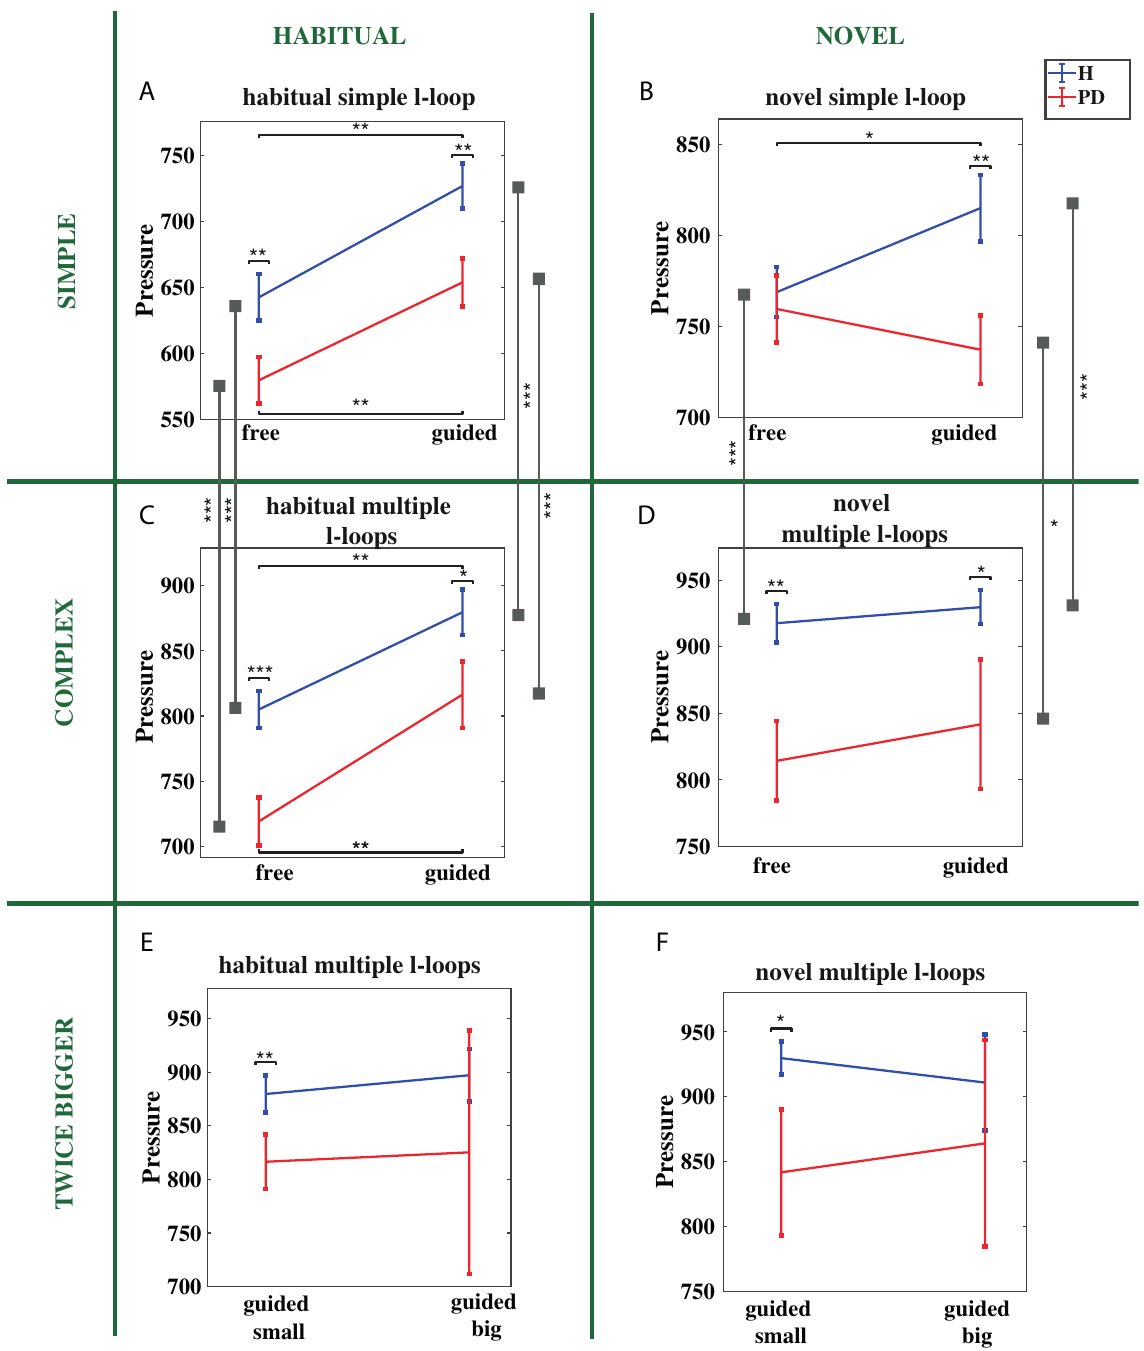
Figure 5. Pressure (mean ± SEM) across PD patients (red lines) and H subjects (blue lines) for all conditions: ( A ) Habitual simple l-loop, ( B ) Novel simple l-loop, ( C ) Habitual multiple l-loops, ( D ) Novel multiple l-loops, ( E ) Habitual multiple l-loops, ( F ) Novel multiple l-loops. Grey and black lines indicate the results of t -tests that gave significant differences. Stars indicate the results one-tailed t -tests corrected with FDR (* p < 0.05; ** p < 0.01; *** p <